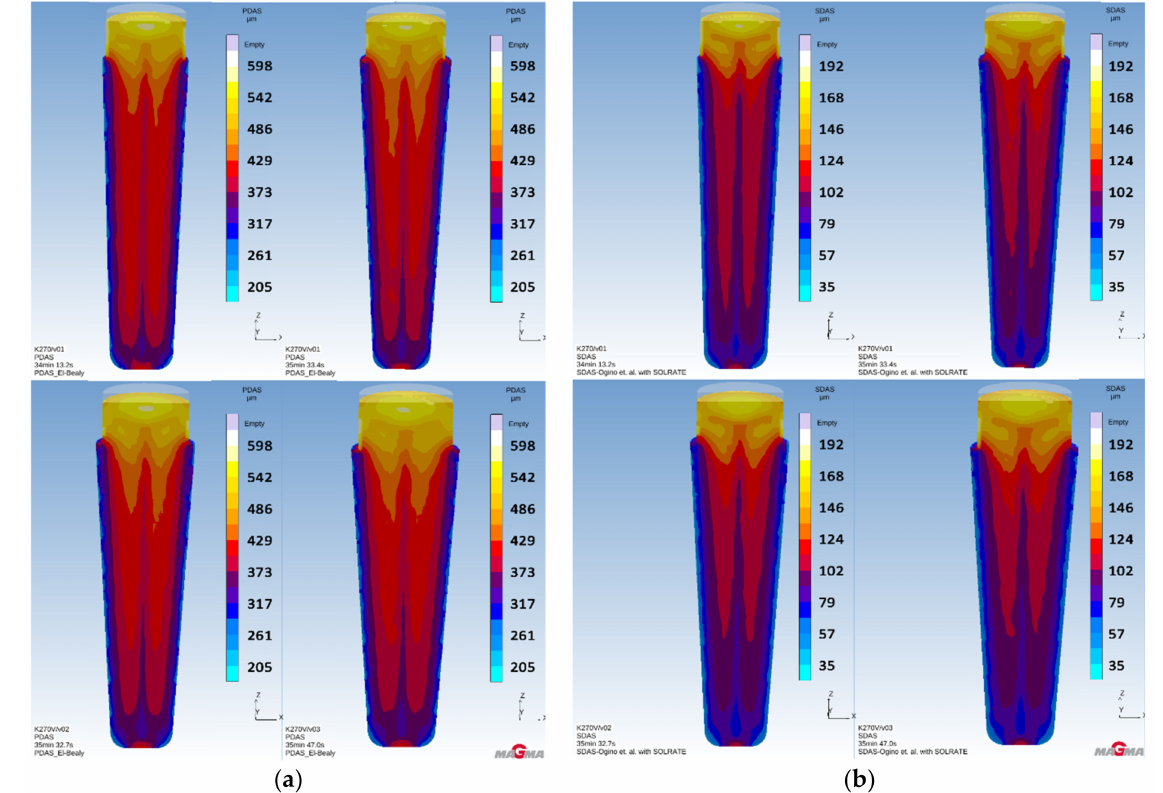
Figure 2. ( a ) Prediction of primary dendrite arm spacing (PDAS)—H/D = 4.25, draft angle 2 ◦ (202.1–594.5 µ m)—(upper left), H/D = 4.25, draft angle 2.3 ◦ (202.3–599.4 µ m)—(upper right), H/D = 3.9, draft angle 2.5 ◦ (205.0–598.5 µ m)—(lower left), H/D = 3.5, draft angle 2.5 ◦ (204.5–600.7 µ m)—(lower right); ( b ) Prediction of PDAS—H/D = 4.25, draft angle 2 ◦ (34.6–190.8 µ m)—(upper left), H/D = 4.25, draft angle 2.3 ◦ (34.6–192.8 µ m)—(upper right), H/D = 3.9, draft angle 2.5 ◦ (35.3–192.6 µ m)—(lower left), H/D = 3.5, draft angle 2.5 ◦ (35.2–194.4 µ m)—(lower